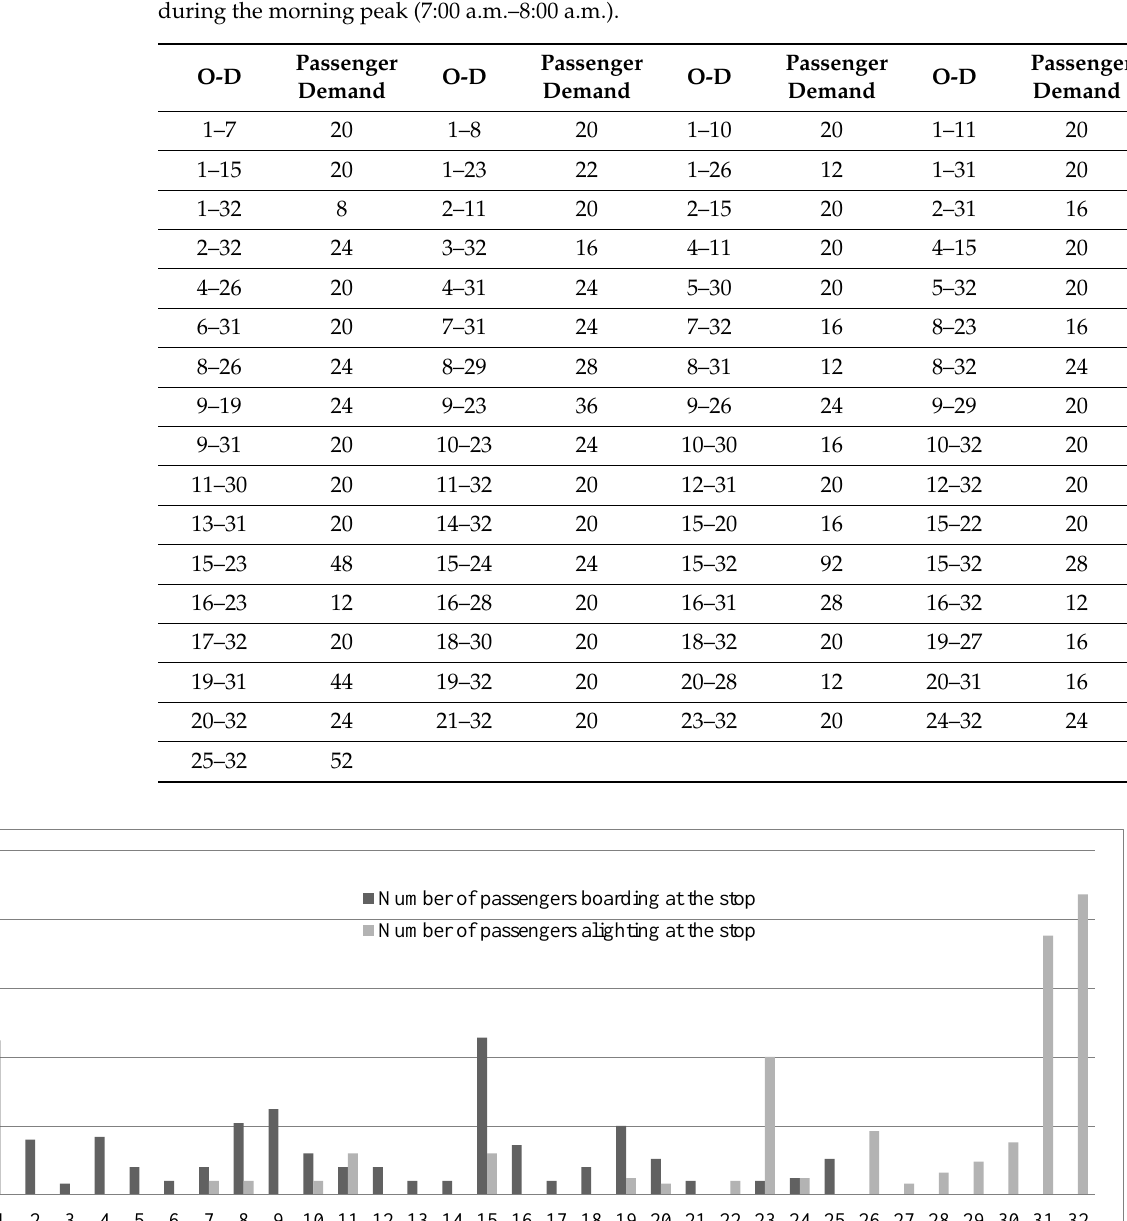
Table 1. OD matrix of Bus Route 202 in the direction of Rongbing → Zhenjiang railway station